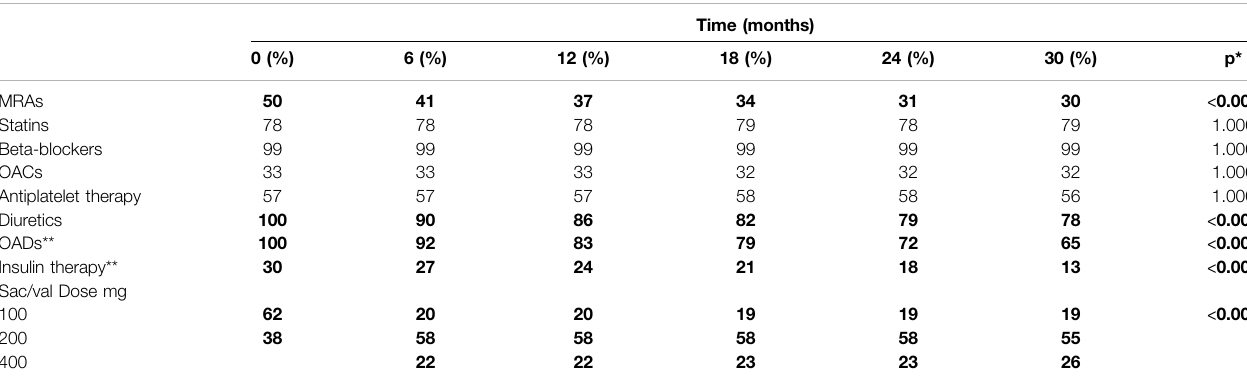
TABLE 2 | Evolution of therapies across